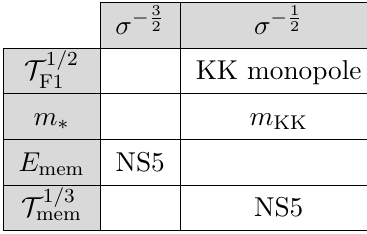
Table 10 . Asymptotic mass scalings along CS flow Im τ a ∼ σ → ∞ , ∀ a